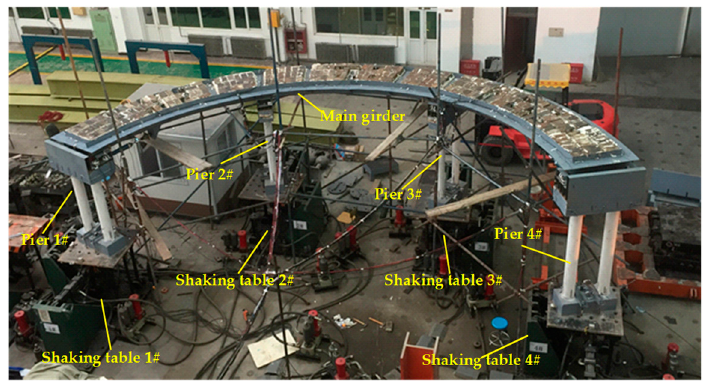
Figure 2. 1/10 curved bridge model.